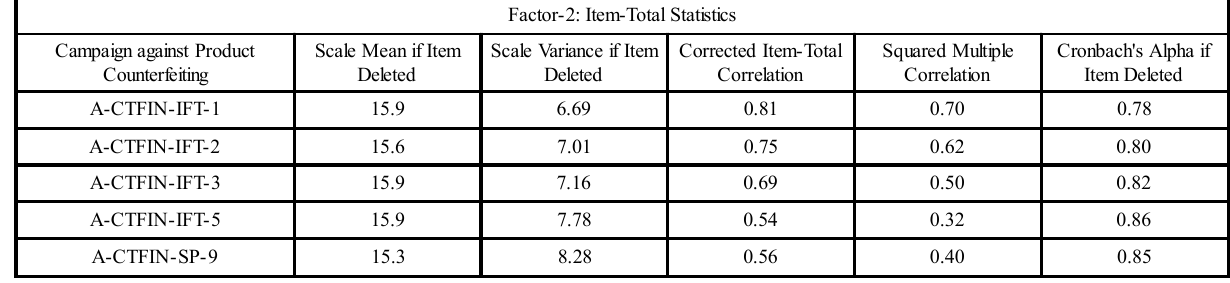
TABLE 21. FACTOR-2; DETAILS OF RELIABILITY STATISTICS